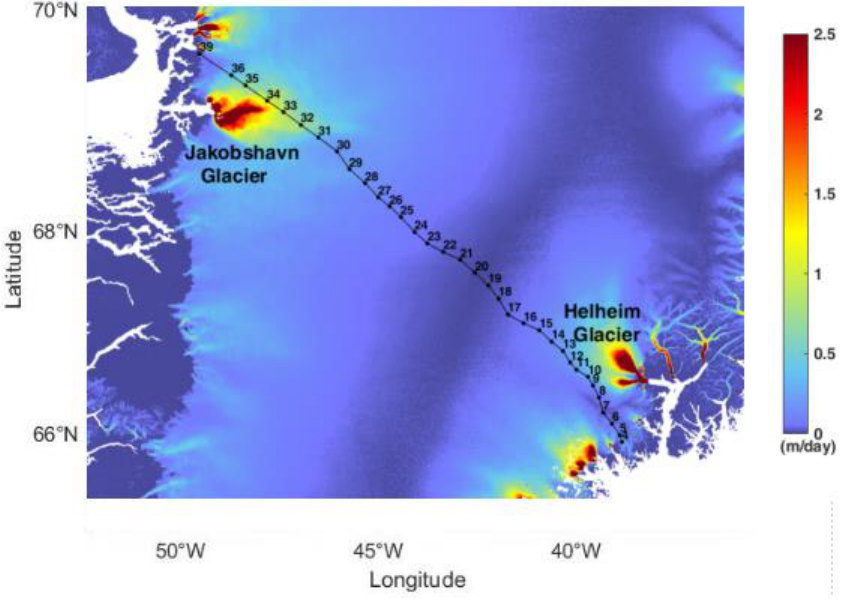
Figure 14. Ice velocity from synthetic aperture radar of Sentinel-1 acquired over October 2015 – September 2016 with camps of the Greenland Korth Expedition route. The direction of glacier flow is from the central axis of the Greenland ice sheet towards the coast [17].